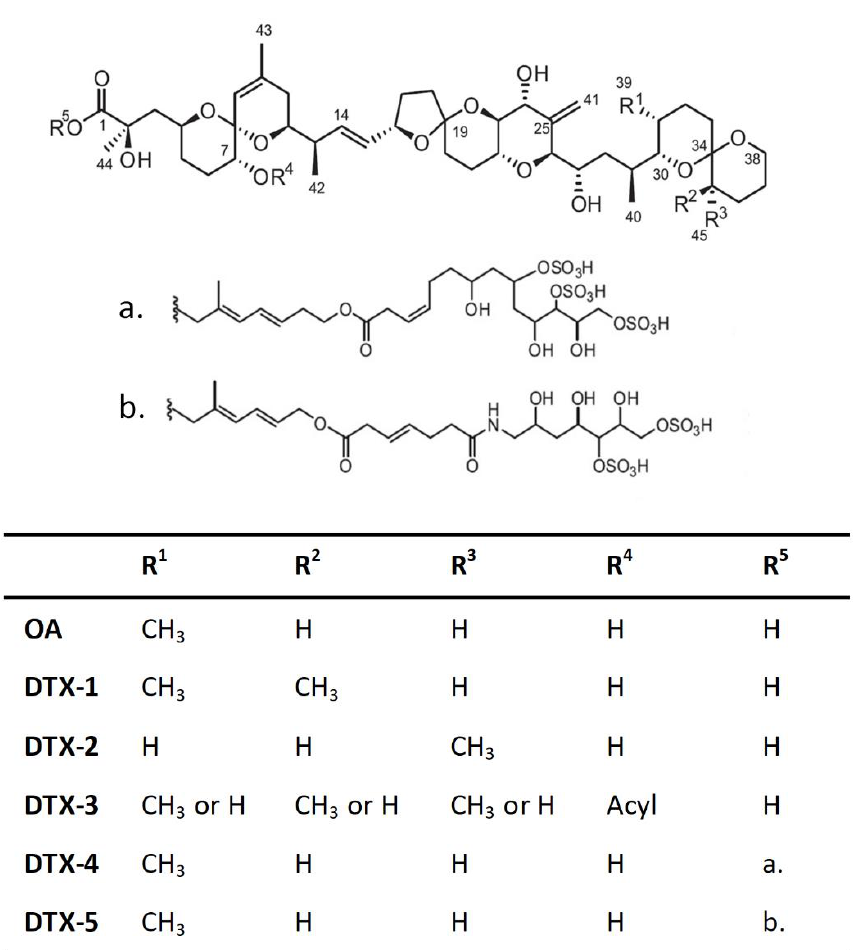
Figure 1. Chemical structure of the main diarrhetic shellfish poisoning (DSP) toxins: Okadaic acid and its derivatives, adapted from [18].